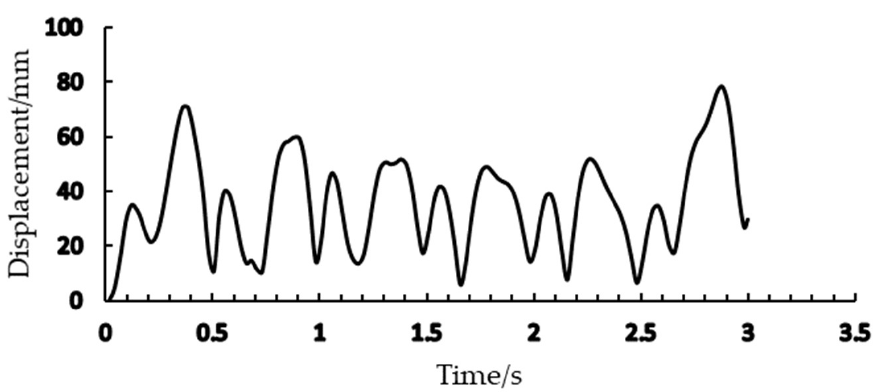
Figure 13. Simulated displacement results of the left end of spray boom.